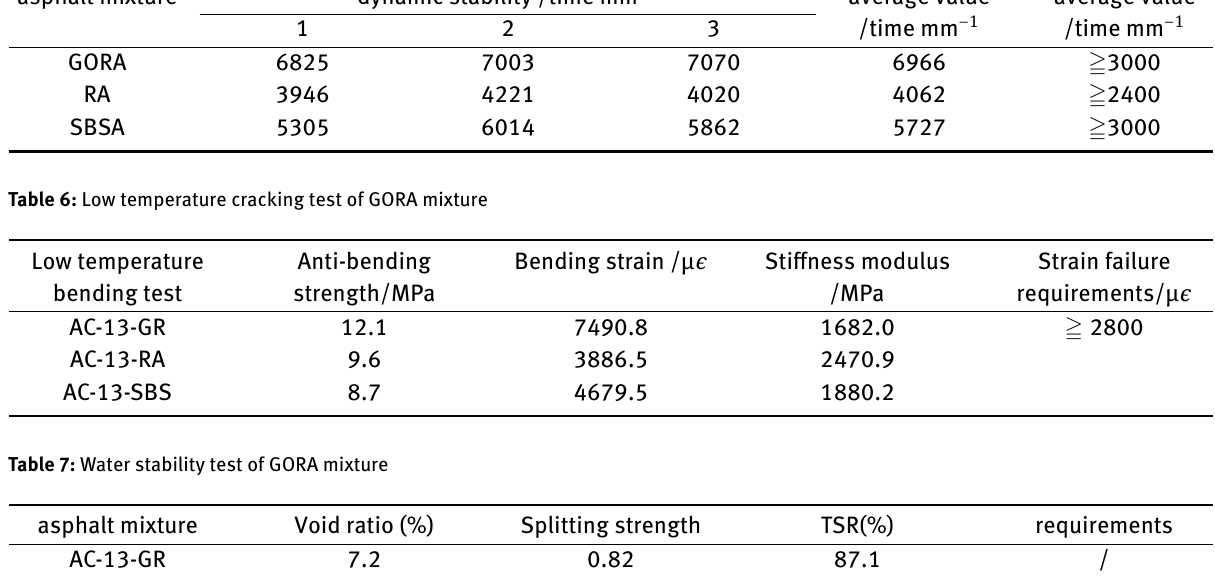
Table 5: Dynamic stability of GORA mixture asphalt mixture